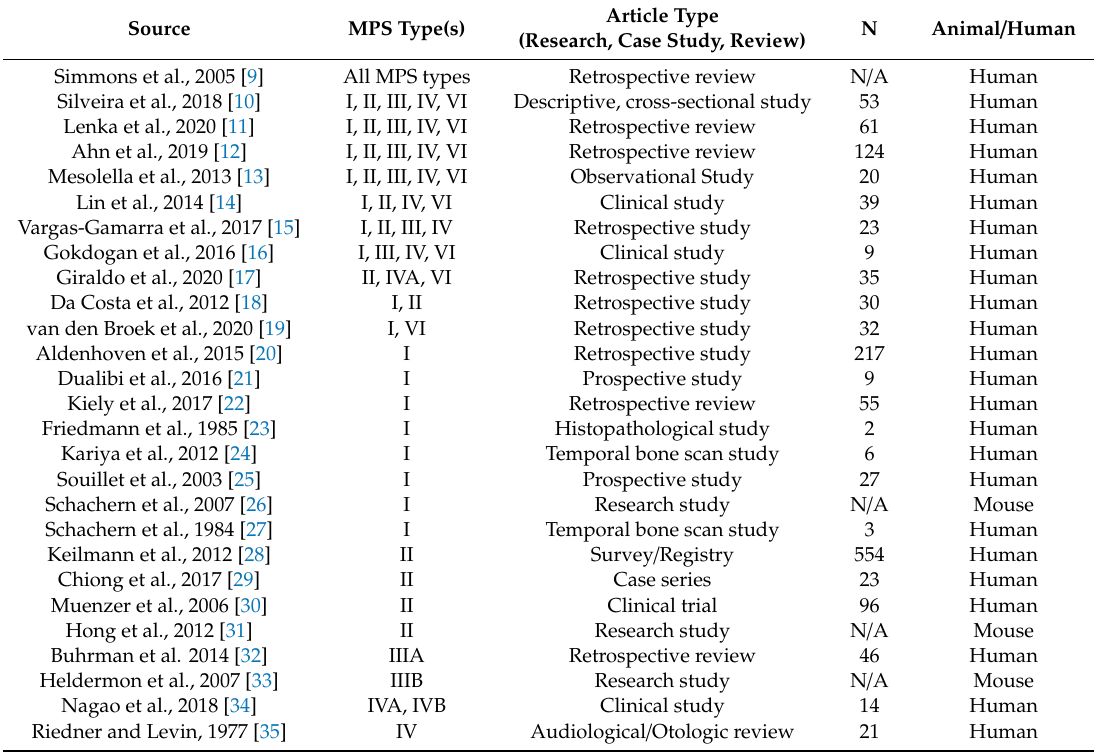
Table 2. Summary of studies on auditory characteristics of